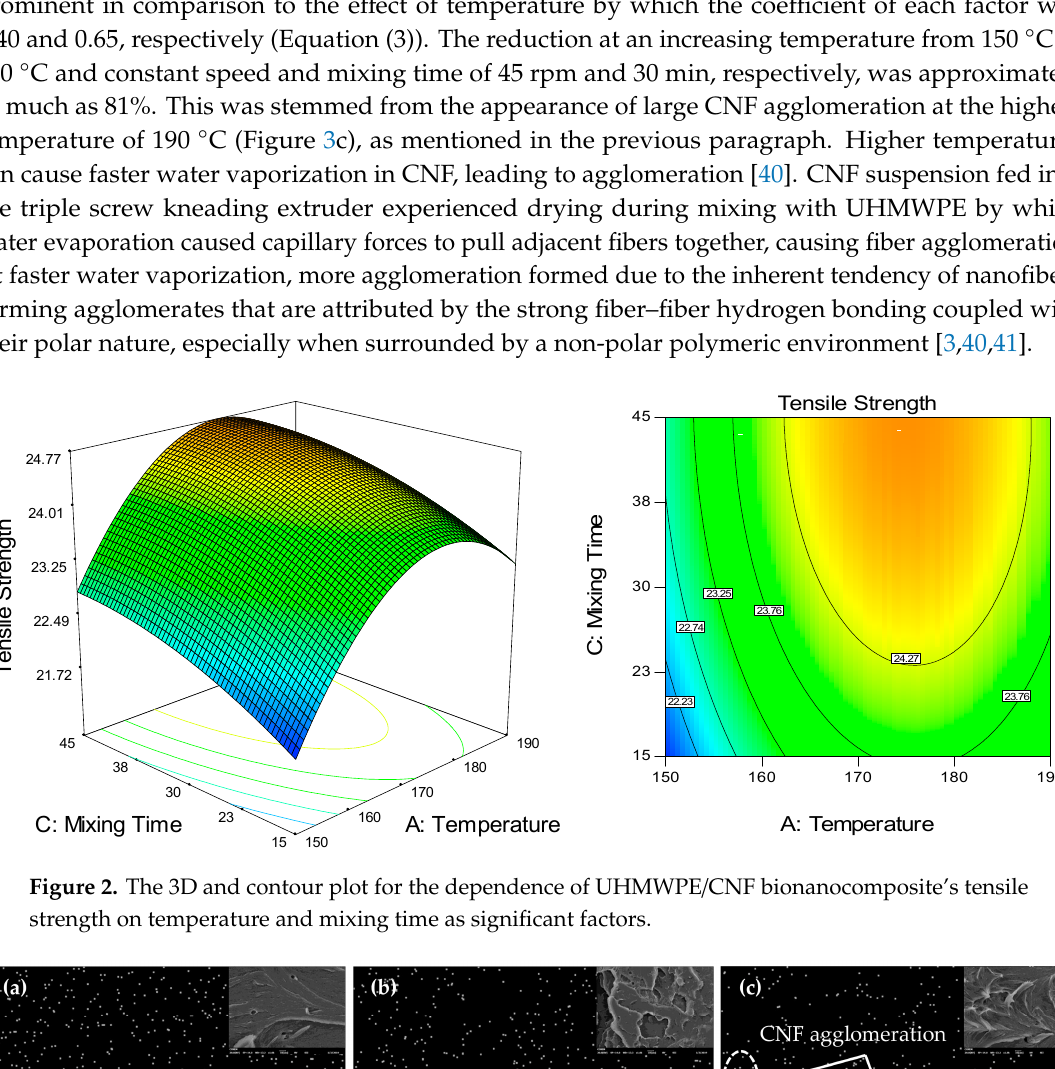
Figure 2. The 3D and contour plot for the dependence of UHMWPE / CNF bionanocomposite’s tensile strength on temperature and mixing time as significant factors.